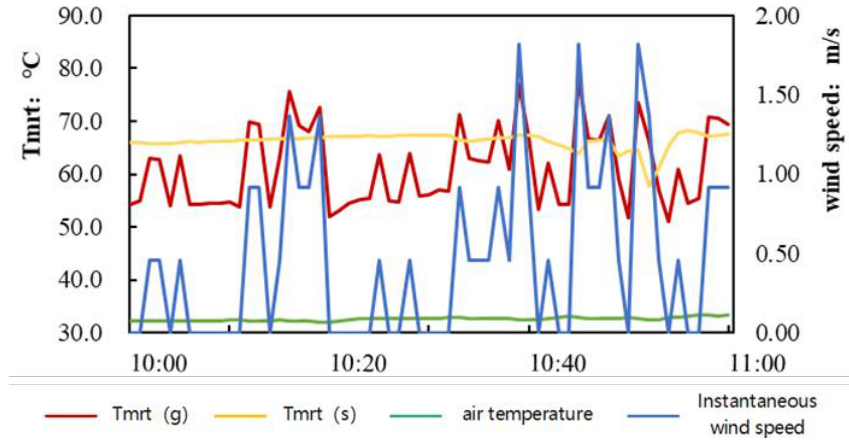
Figure 8. Tmrt (s) and Tmrt (g) at different wind speeds.